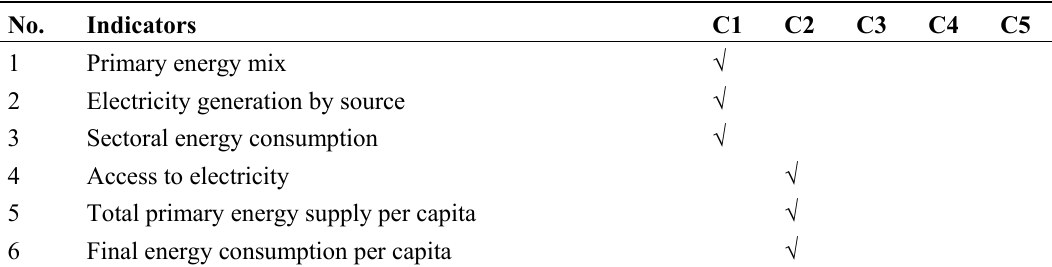
Table 1. List of selected energy security